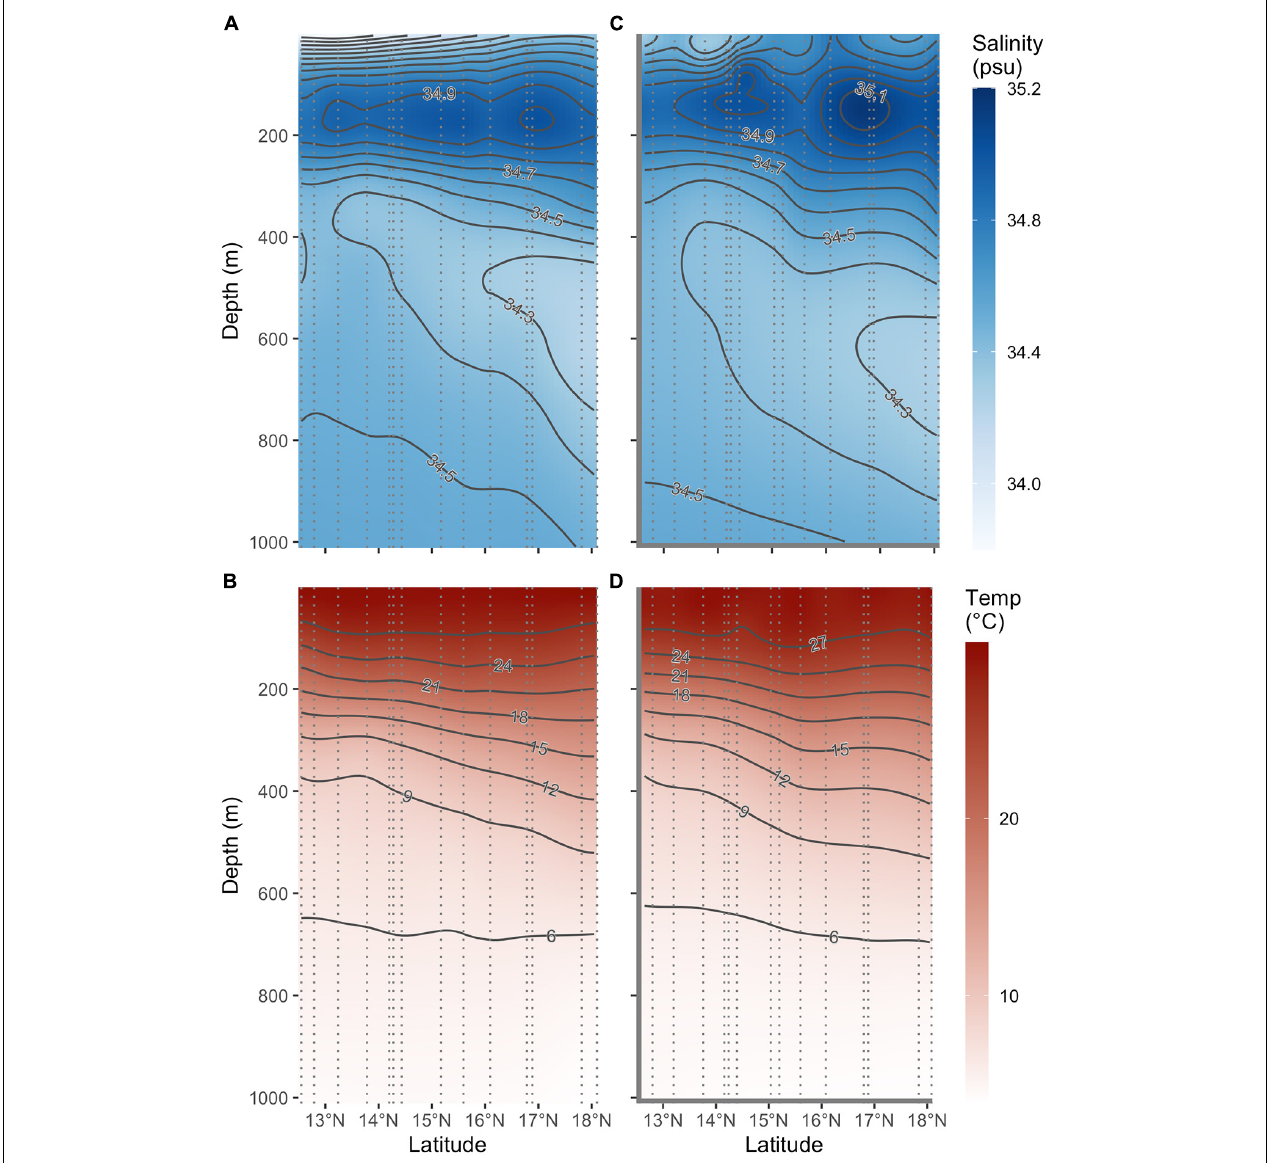
FIGURE 3 | Salinity (A,C) and Temperature (B,D) depth profiles from south to north in the study area derived from data collected on conductivity-temperature-depth (CTD) casts (A,B) during the survey and output from an ocean circulation model, HYCOM (C,D) . The light gray dotted lines show the location of the CTD cast, and the data have been interpolated using LOESS with a 20% smoother. Note that the longitudes for the CTD casts are not the same but collected within a 3-degree spatial